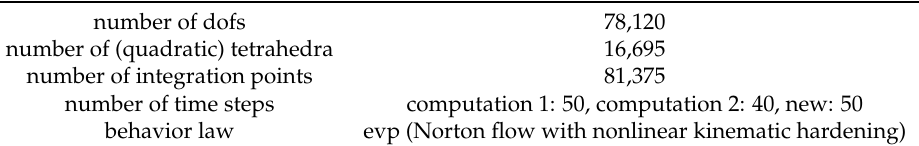
Table 1. Characteristics for the academic test